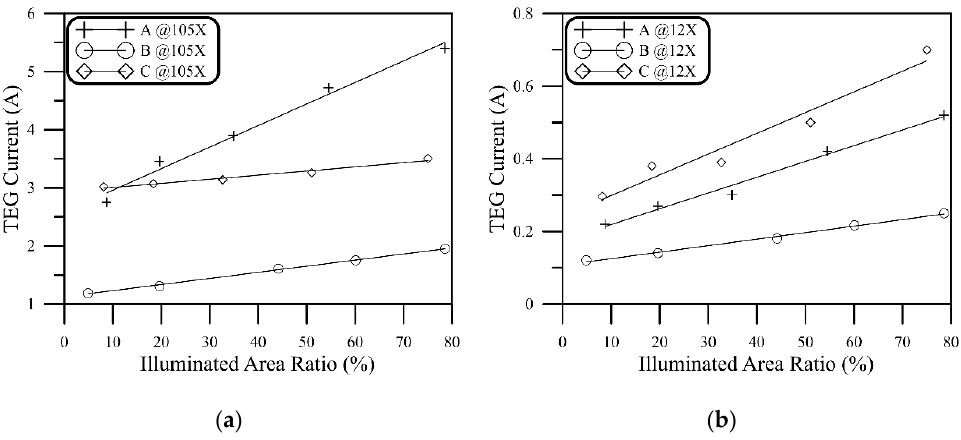
Figure 7. Short-circuit current as a function of percentage of the illuminated area on the hot surfaces of the TEG samples under light intensity of ( a ) 105 × and ( b ) 12 × .